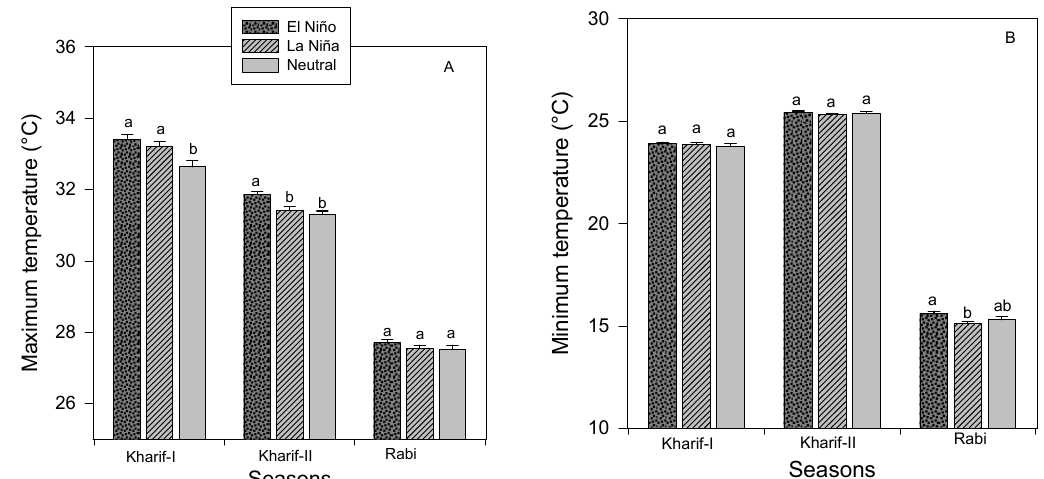
Figure 3. Impacts of ENSO on maximum temperature ( A ) and minimum temperature ( B ) composite during Kharif-I, Kharif-II and Rabi seasons for all selected stations in coastal Bangladesh. Means that do not share same letters are statistically significant (Tukey’s b, α = 5%). The error bars represent the standard error of the means.